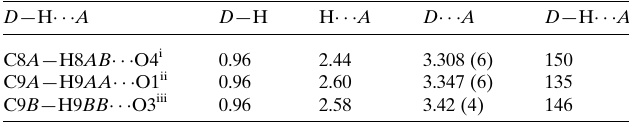
Table 1 Hydrogen-bond geometry (A˚ , (cid:5) ).